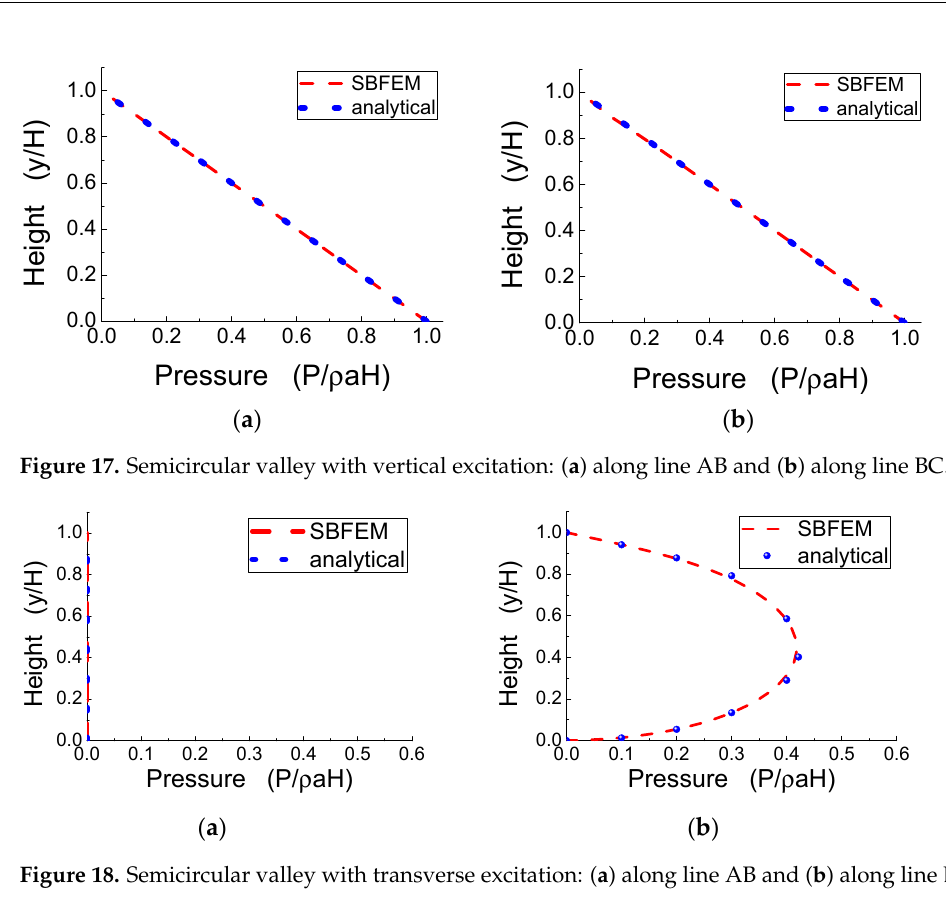
Figure 16. Semi-circular valley with upstream–downstream excitation: ( a ) along line AB and ( b ) along line BC.